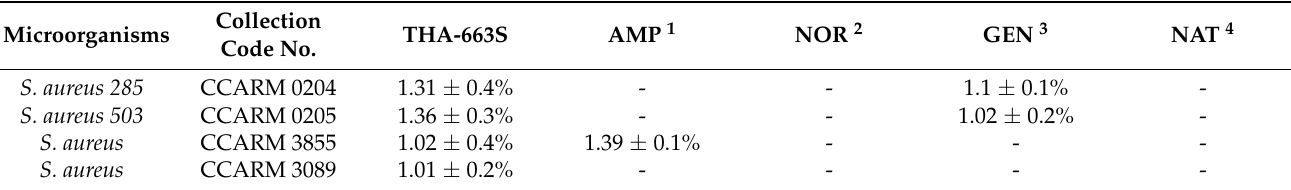
Table 3. Antibacterial effect of THA-663S on MRSA.